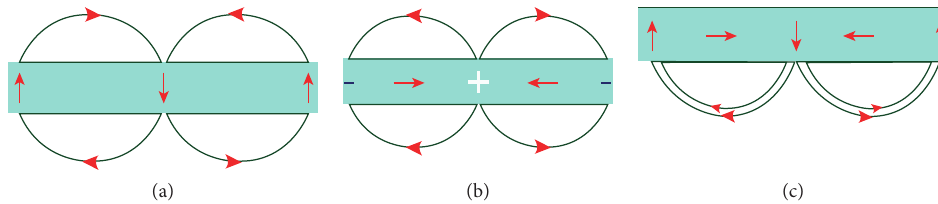
Figure 3: A schematic principle of the Halbach magnetic adsorption array. (a) m